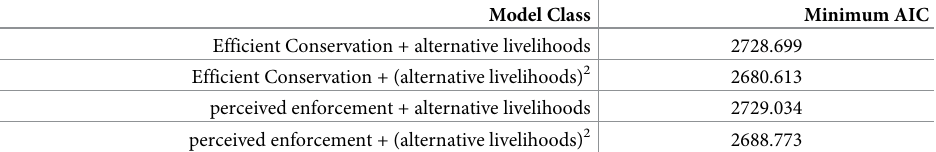
Table 3. Minimum AIC for four different model classes. Minimum AIC over all 128 subset models in each model class. All models are fitted to randomized responses based on the EM algorithm with 20 different random starting val- ues to avoid convergence to local modes.